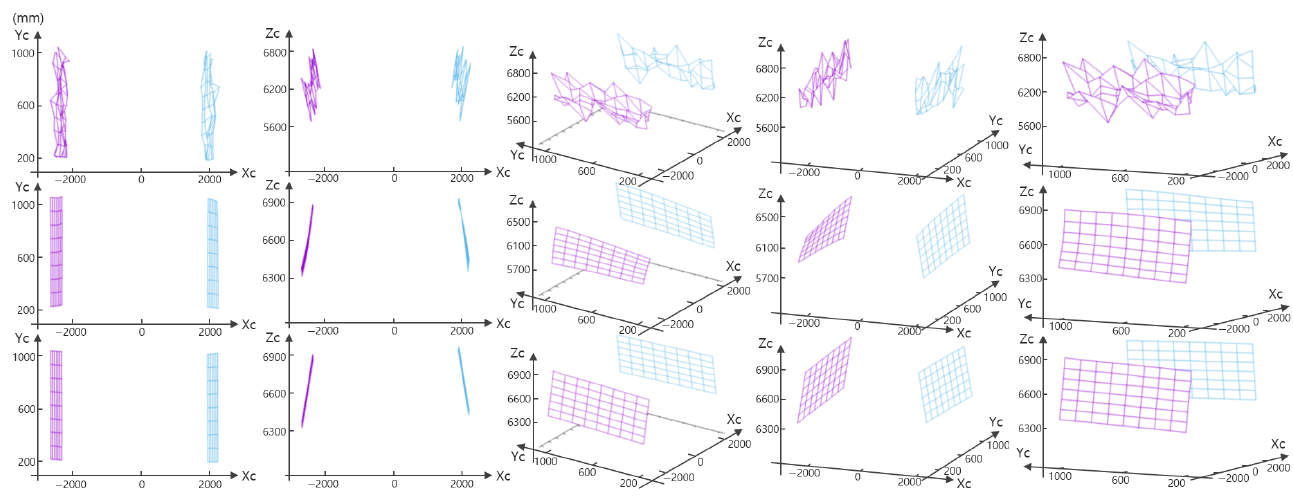
Figure 2. Reconstructed 3D points by using Naïve triangulation ( top row), optimal planar reconstruction ( middle row), and proposed reconstruction method ( bottom row) in different